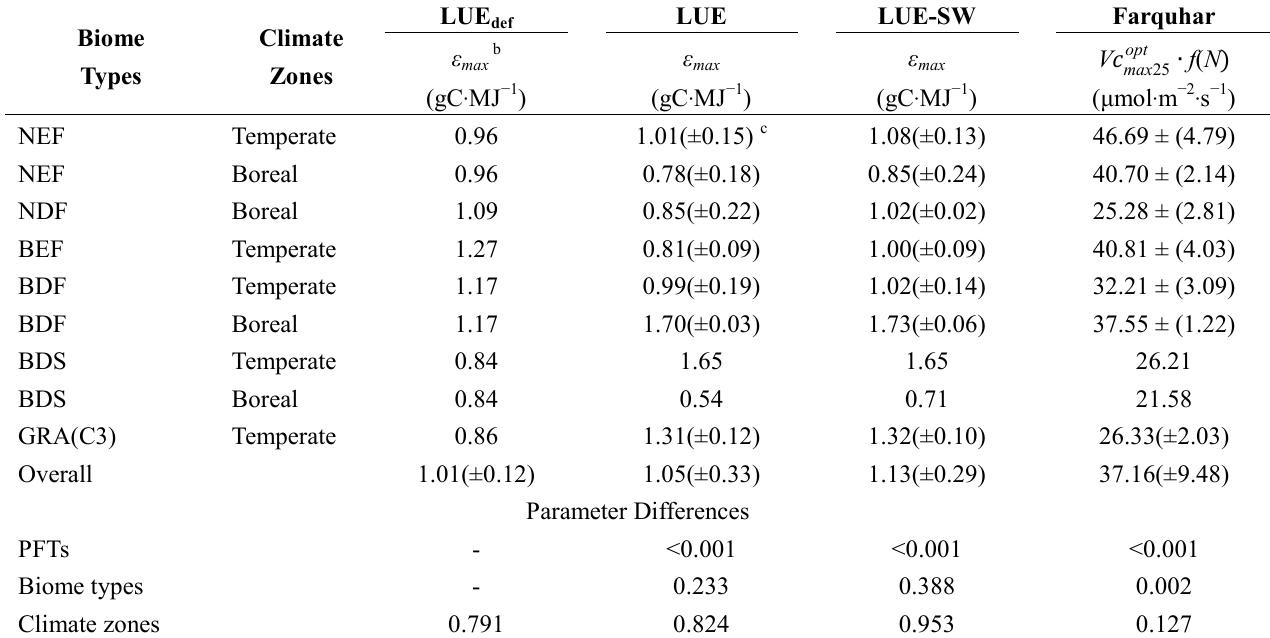
Table 2. Model parameters a derived from the 21 selected tower sites for nine plant functional types. Parameter differences among plant functional types, biome types and climate zones were determined using the one-way analysis of